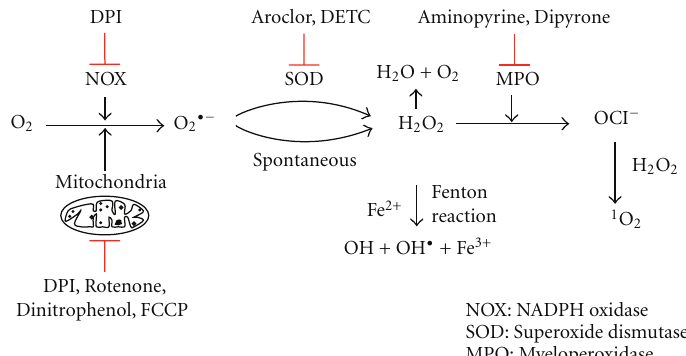
Figure 1: Generation and inhibition of ROS in neutrophils. The generation of superoxide (O 2 •− ) from oxygen (O 2 ) is mediated either by the NADPH oxidase complex (NOX) or in mitochondria by cytochrome c peroxidase or xanthine oxidase. Superoxide will be converted to hydrogen peroxide (H 2 O 2 ) either spontaneously or mediated by superoxide dismutase (SOD). Hydrogen peroxide is a source of hydroxyl radical (OH • ) via the Fenton reaction. Myeloperoxidase uses hydrogen peroxide as substrate for the formation of halogenated ROS such as hypochlorite (OCl − ). Reaction of hypochlorite with hydrogen peroxide will result in the formation of singlet oxygen ( 1 O 2 ). The e ff ect of the inhibitors used in the study (10 µ M Rotenone, 10 µ M Dinitrophenol, 500 nM FCCP, 20 µ M DPI, 38 µ M Aroclor, 10 µ M DETC, 200 µ M Dipyrone and 200 µ M Aminopyrine) is